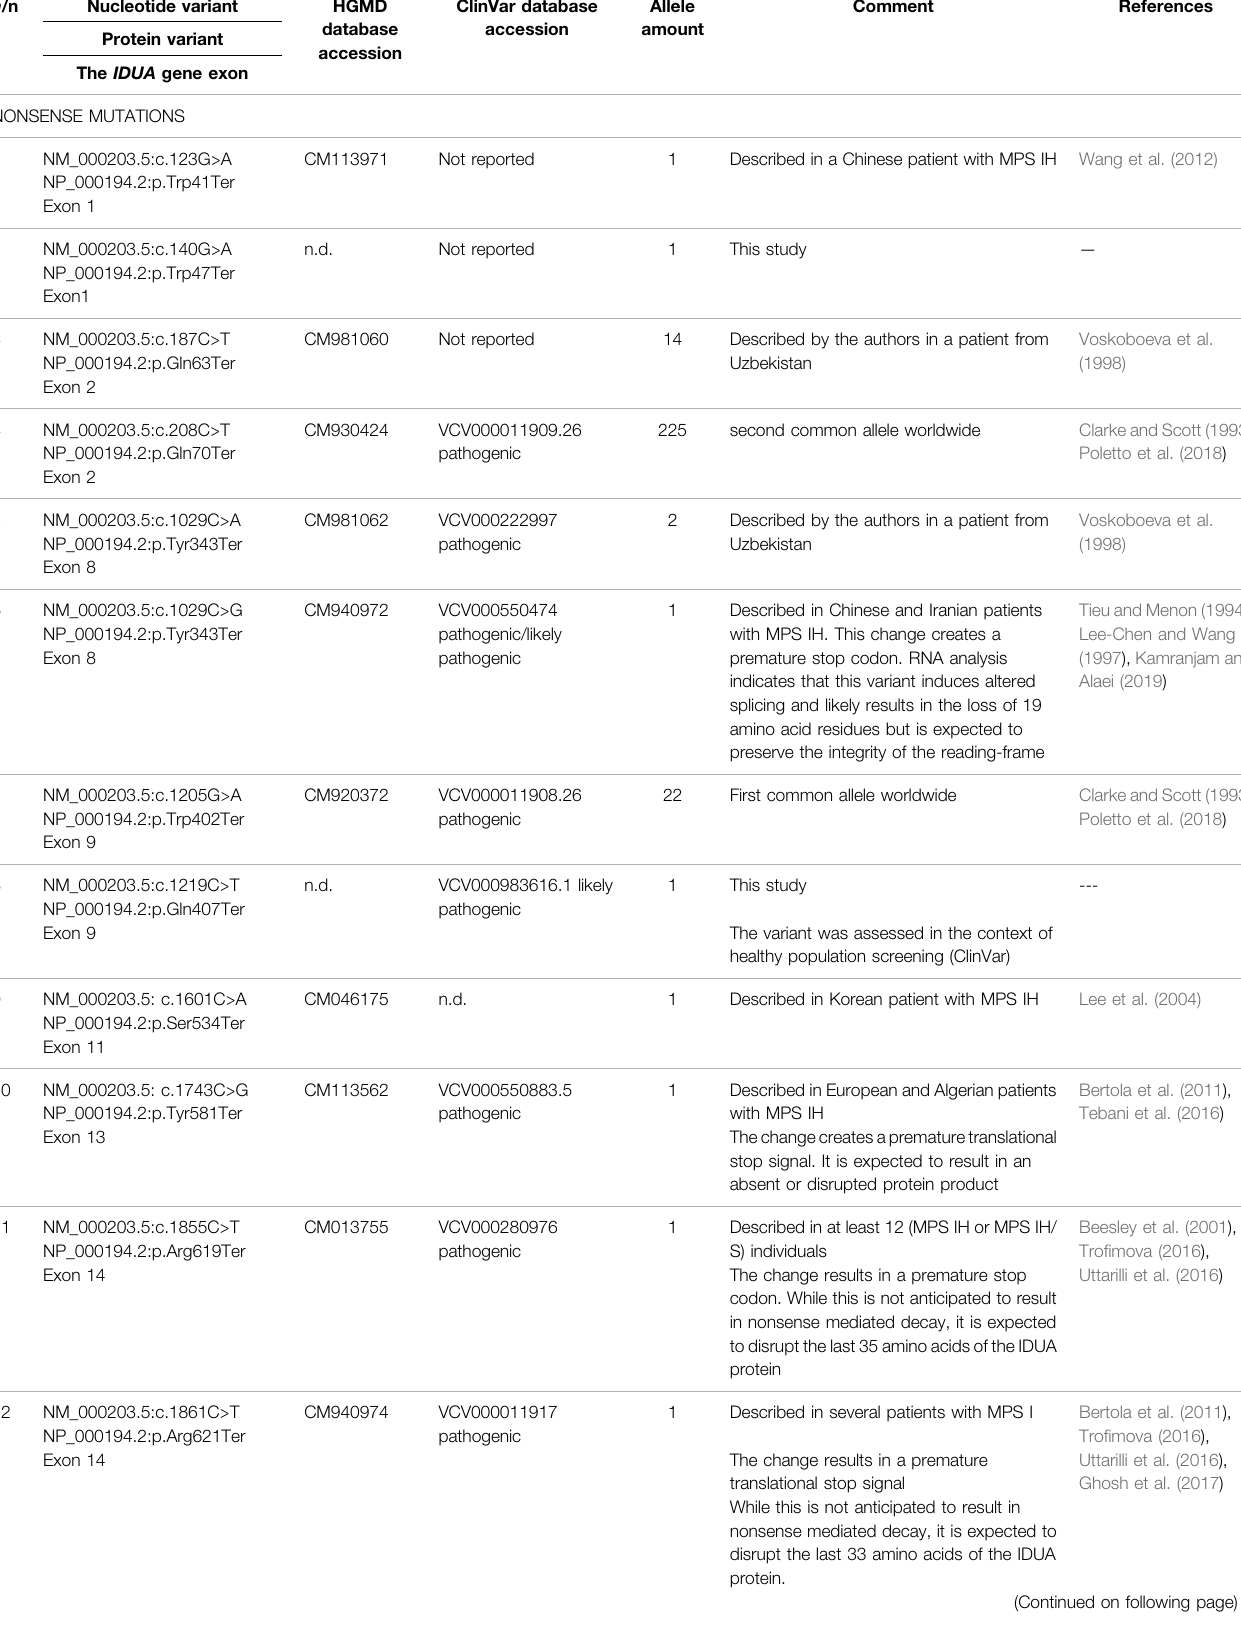
TABLE 2 | Characteristics of the nucleotide variants detected in the IDUA